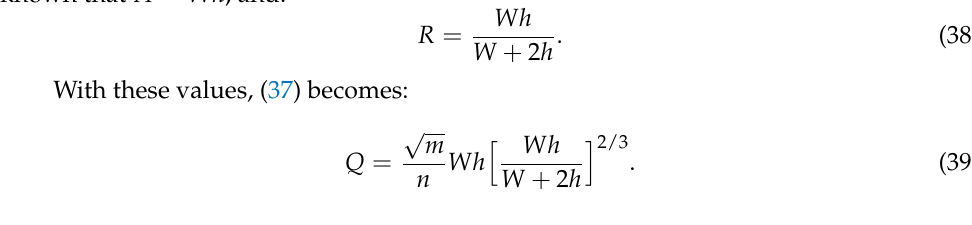
Table 6. Numerical results for problem 2 ( f 4 ( x )) with two different initial guesses.